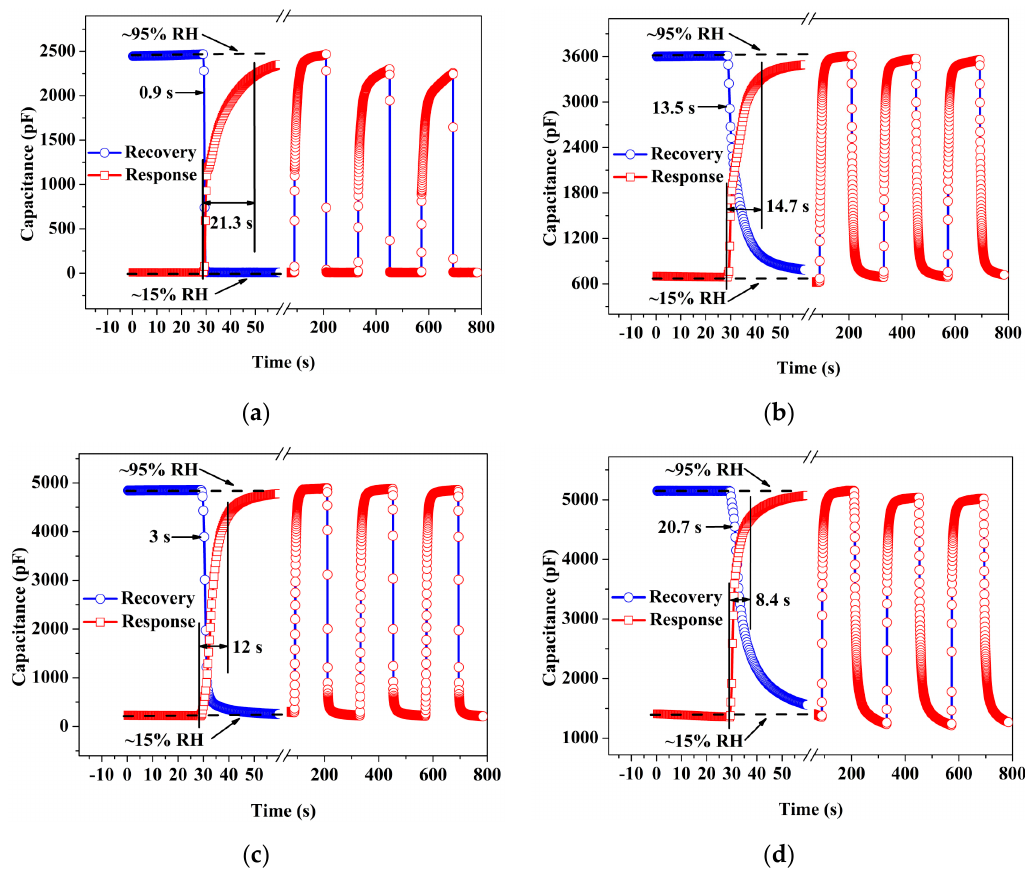
Figure 6. The response-recovery behavior and repeatability of ( a ) ZnO, ( b ) PVP-RGO, ( c ) ZnO/PVP-RGO, and ( d ) PVP-RGO/ZnO sensors when the relative humidity changed rapidly between 15% and 95% RH at room temperature. Table 1. Comparison in performance towards previous work.